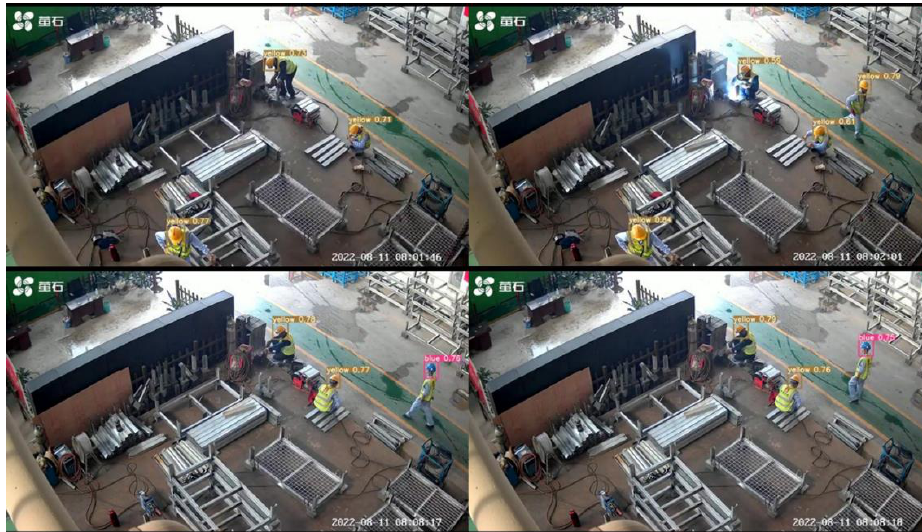
Figure 9. Examples of test results on video. Table 4. Comparison of testing results on video.